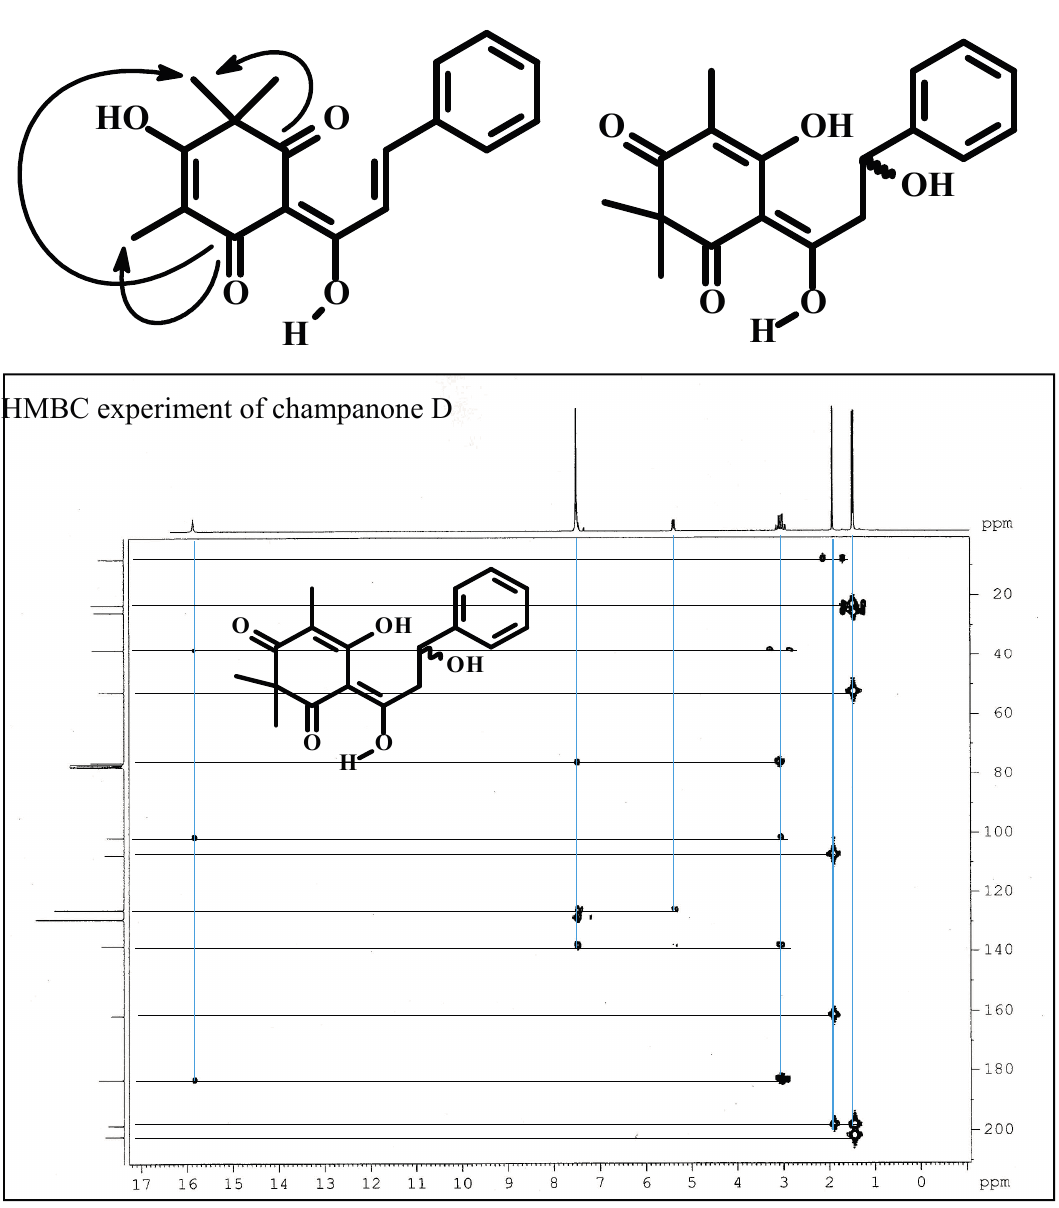
Figure 2. Improbable (left) and correct (right) structures of champanone D and HMBC 1 H- 13